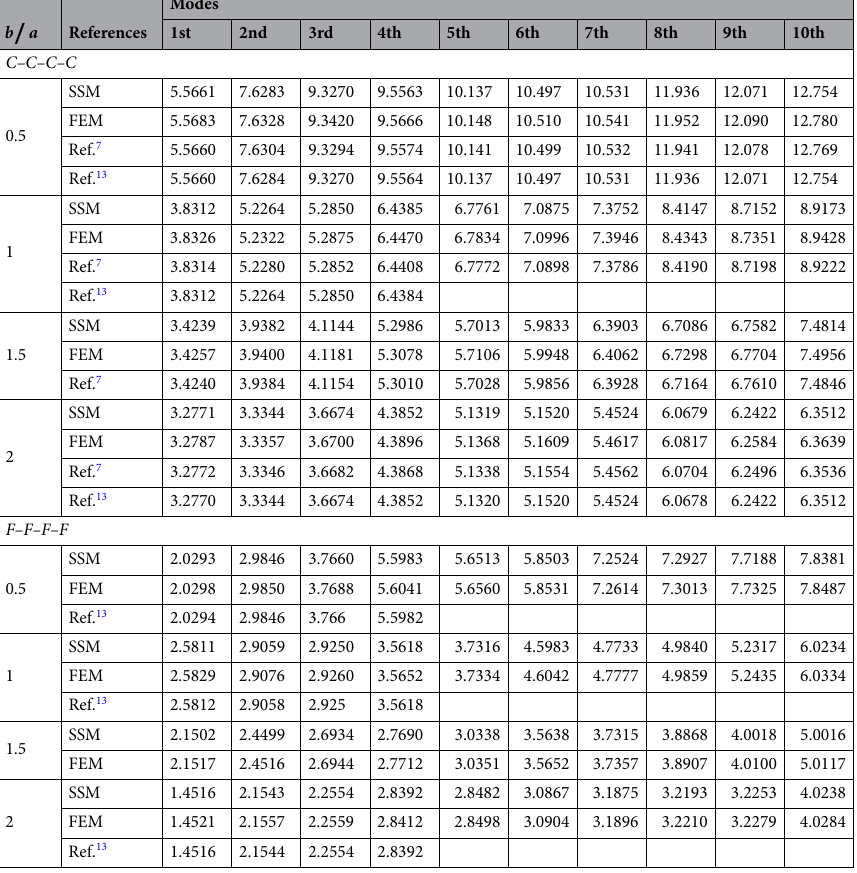
Table 2. The first ten frequency parameters ( (cid:31) ort ) of orthotropic plates with E y